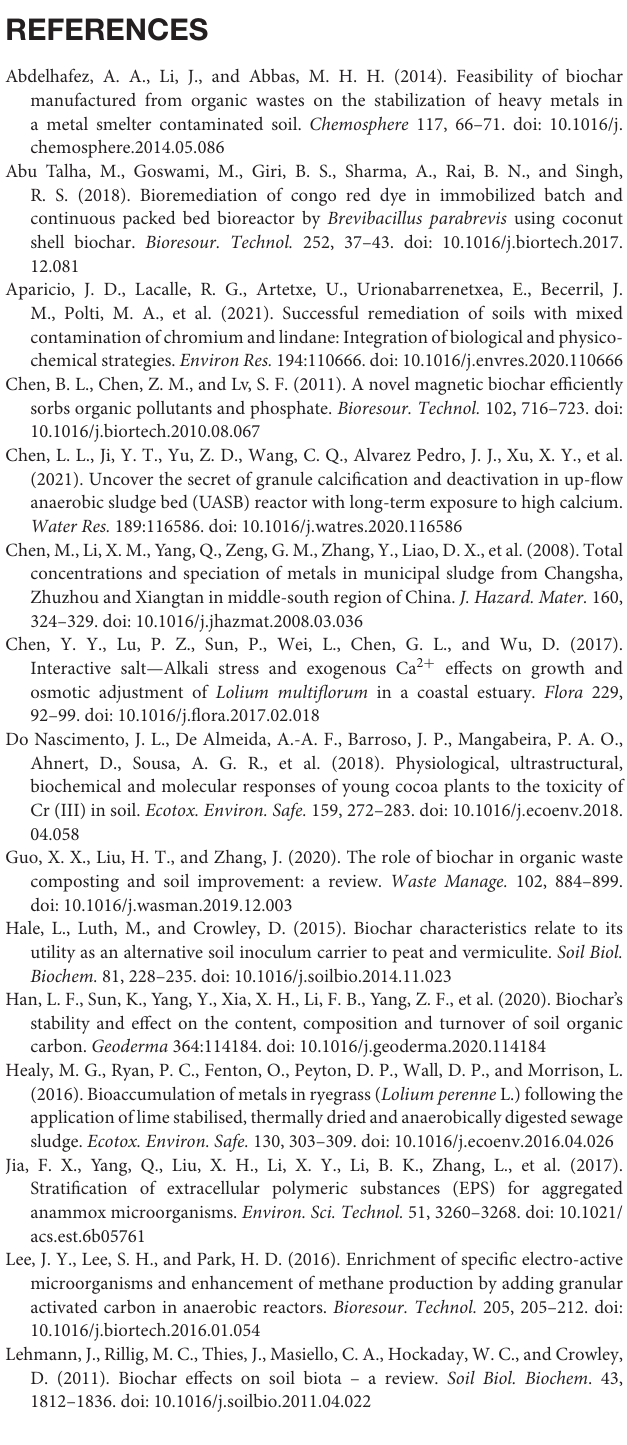
Supplementary Figure 1 | Growth of Ryegrass with different remediation methods after 30 days. Supplementary Figure 2 | The physiological characteristics of Ryegrass with different remediation methods. (A) Chlorophyll. (B) Root length. (C) Plant height. (D) Plant weight and ratio of dry weight and fresh weight.